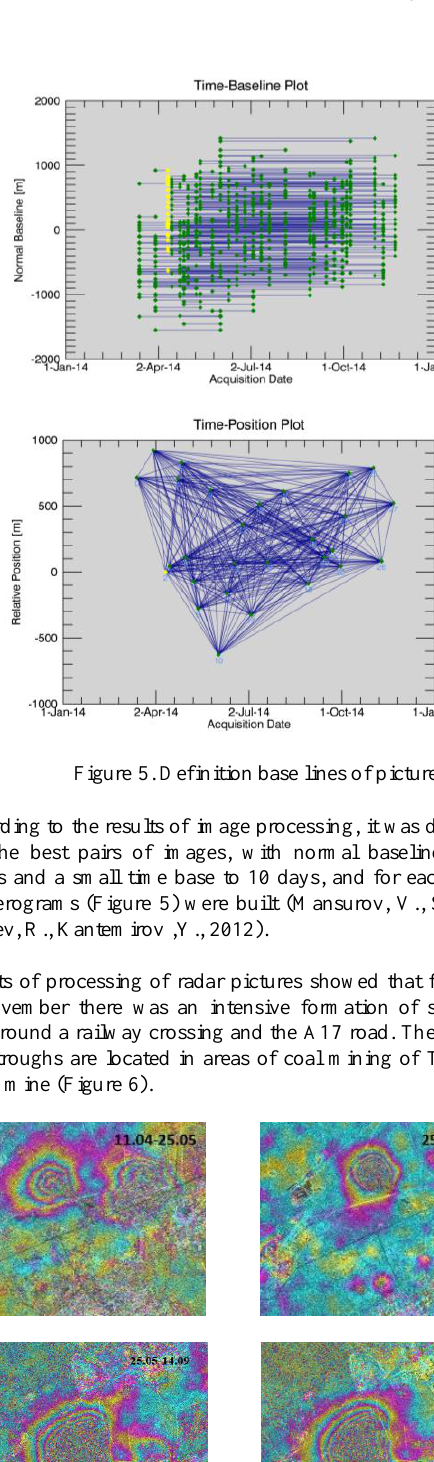
Figure 8. The reconstructed electric transmission lines, which are on the undermined territory of Kuzembaev